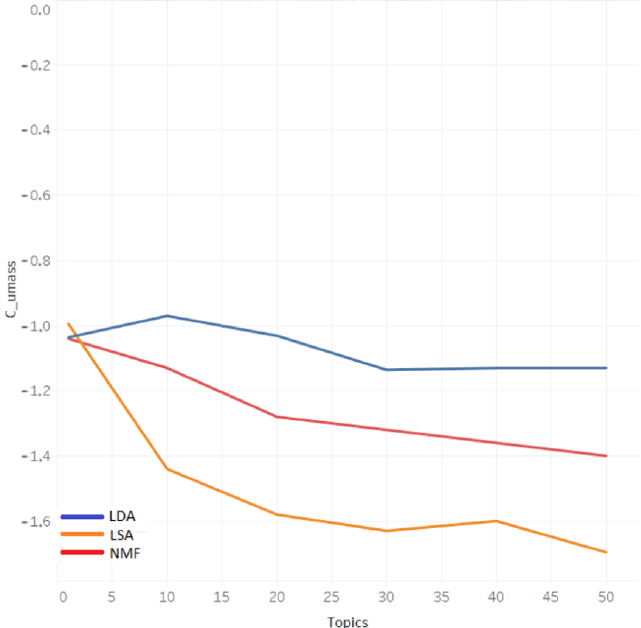
Figure 7. C_umass of LDA, LSA, and NMF with a k of 1 through 50.